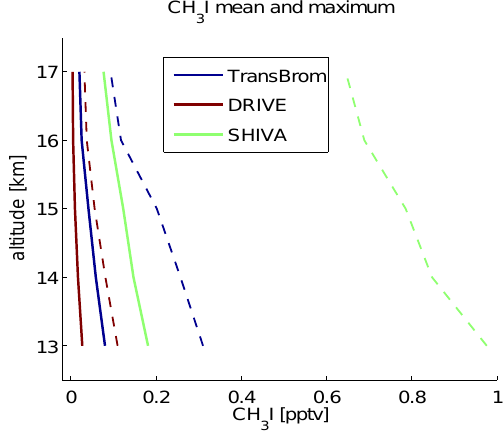
Fig. 5. Modeled CH 3 I profiles based on observed emissions during the TransBrom, DRIVE and SHIVA ship campaigns. For all three campaigns mean values (solid lines) and maximum values (dashed lines) are